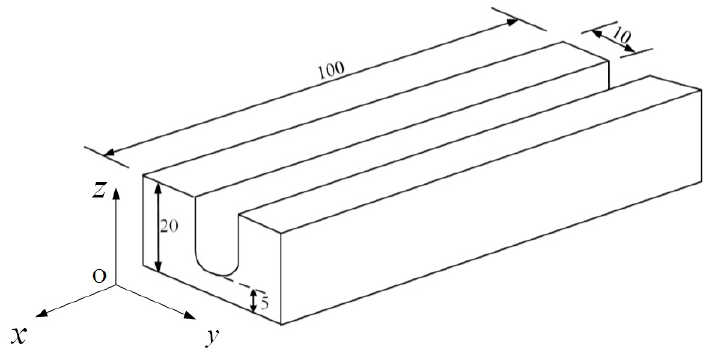
Figure 4. 3D computational domain.